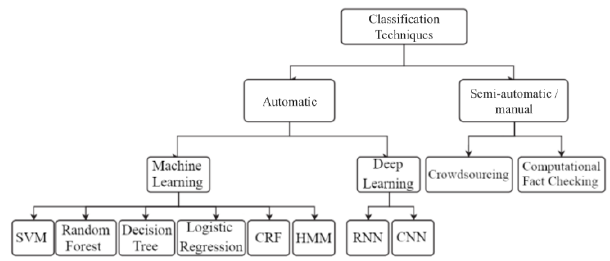
Figure 1. Different approaches proposed for detecting fake news found in the literature. Source : translated from Medeiros & Braga (2020, p. 3)